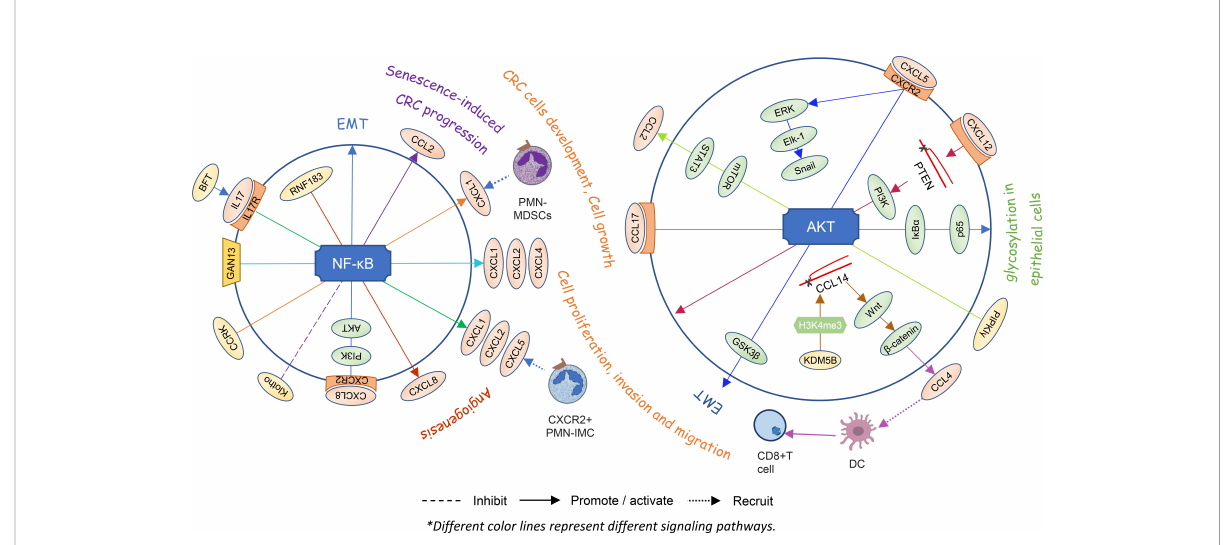
FIGURE 3 Chemokines and signaling pathways within cells directly affect each other ’ s states and the angiogenesis or proliferation and invasion of colorectal